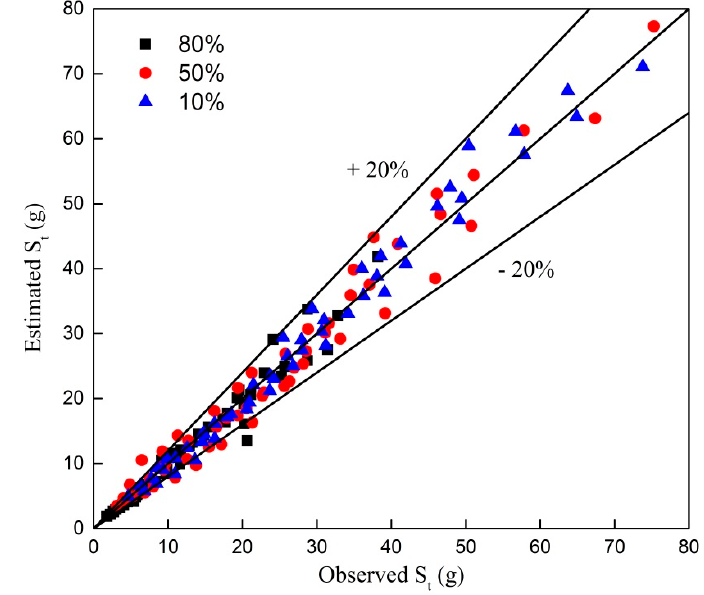
Figure 9. Comparison between the observed and estimated values of splashed particles.